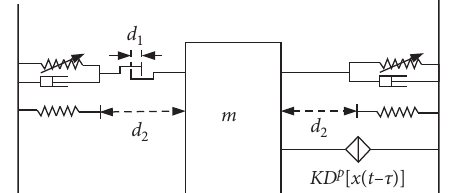
Figure 1: Nonlinear systems with piecewise time